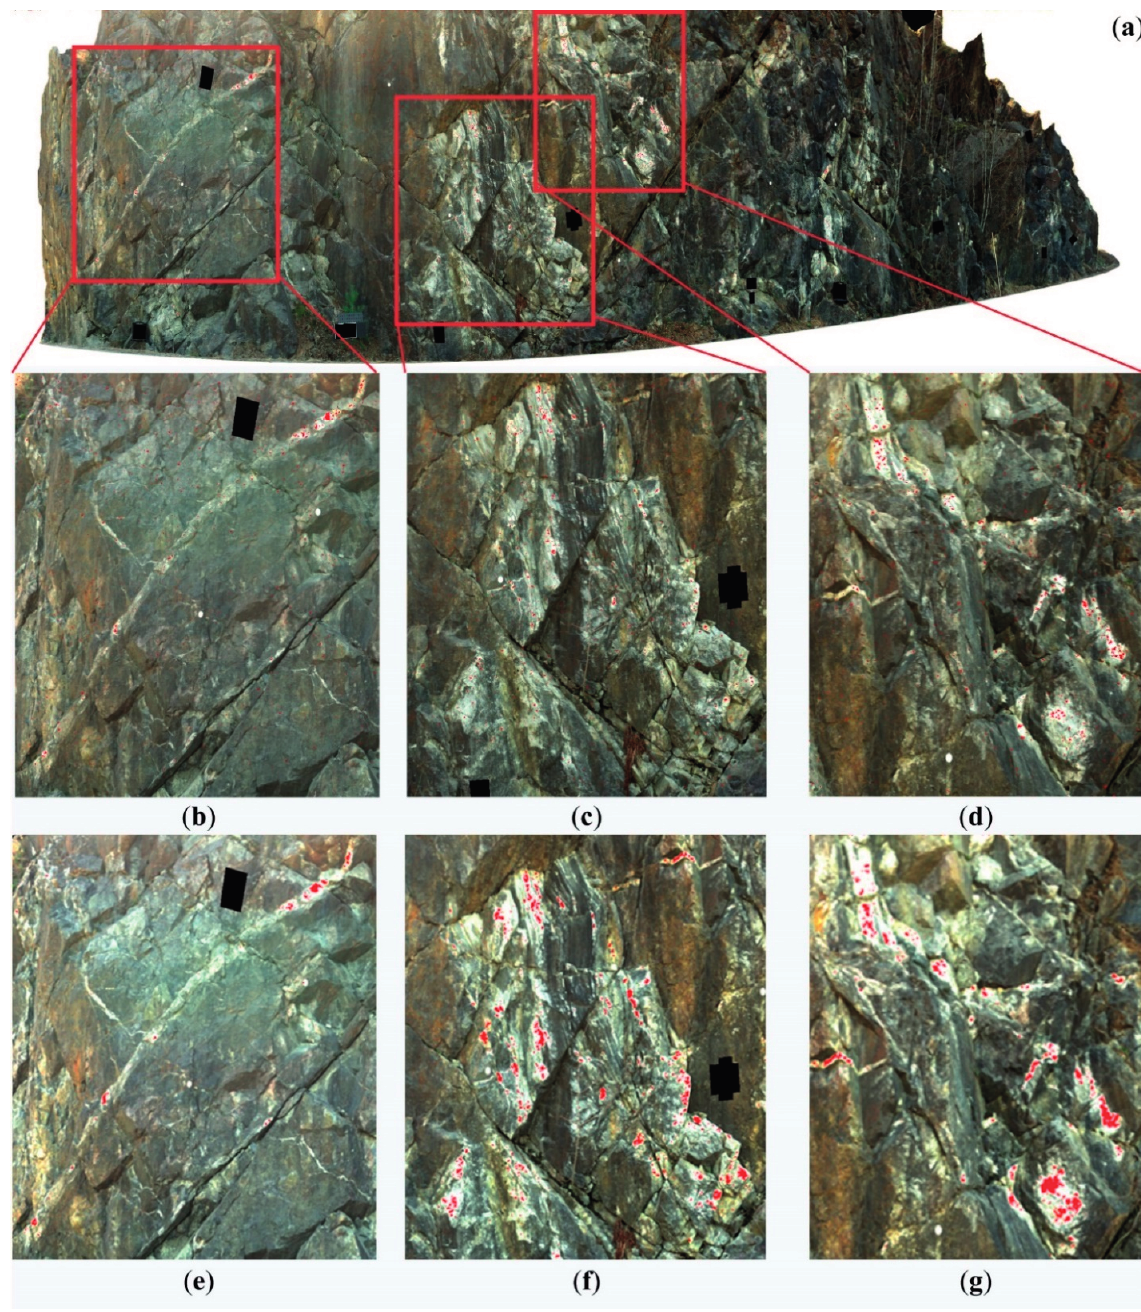
Figure 9. REE thematic map based on the simple algorithm (without R-L deconvolution). Enriched zones cannot be identified at their full spatial extent. ( a ) Shows the full extent of the map; ( b – d ) are zoom images at where the original approach shows the most positive findings. Here, only some pixels could be identified correctly. For comparison, the results of the full approach shown in Figure 6b–d are shown in the zoom images ( e – g ). Modified after Boesche et al. 2014